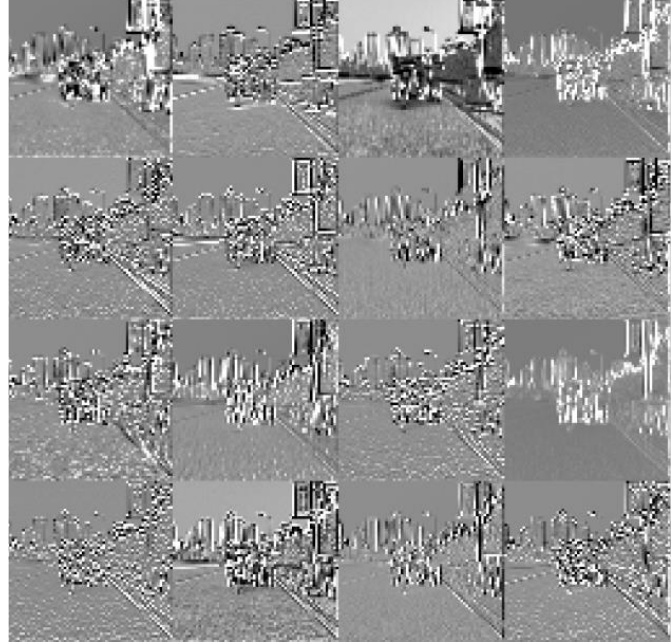
Figure 13. Network intermediate visible feature maps.